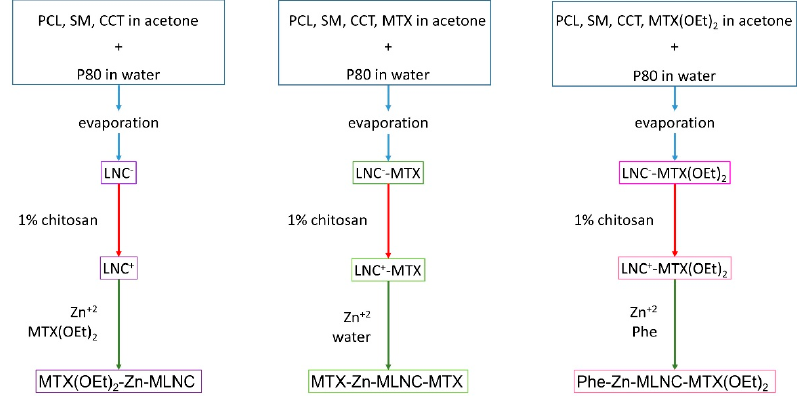
Figure 1. Scheme of synthesis: lecithin-polysorbate 80-coated lipid-core nanocapsules (LNC − ) containing or not drug, methotrexate (MTX) or methotrexate diethyl ester [MTX(OEt) 2 ], prepared using poly( ε -caprolactone) (PCL), sorbitan monostearate (SM) and capric-caprylic triglyceride (CCT), were reacted with 1% chitosan producing chitosan-lecithin-polysorbate 80-coated lipid-core nanocapsules [LNC + , LNC + -MTX or LNC + -MTX(OEt) 2 ], which were used to obtain multiwall lipid-core nanocapsules (MLNC) complexed with Zn 2+ and (i) methotrexate diethyl ester [MTX(OEt) 2 -Zn-MLNC]; (ii) encapsulated and functionalized methotrexate (MTX-Zn-MLNC-MTX); and (iii) methotrexate diethyl ester-encapsulated in the multiwall lipid-core nanocapsules which surface is passivate with phenylalanine [Phe-Zn-MLNC-MTX(OEt) 2 ].